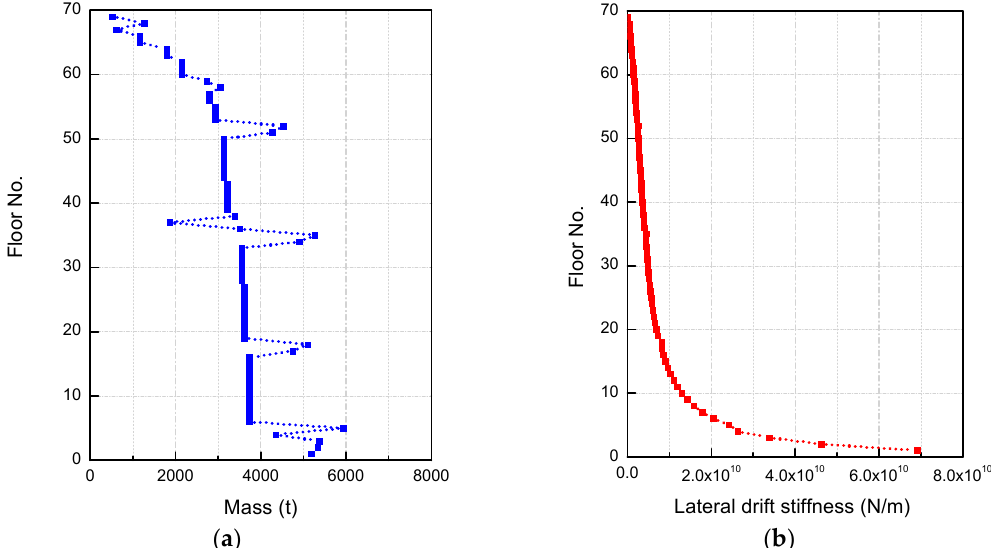
Figure 3. Dynamic properties of the benchmark building extracted from the finite element model: ( a ) mass distribution; ( b ) lateral stiffness distribution.